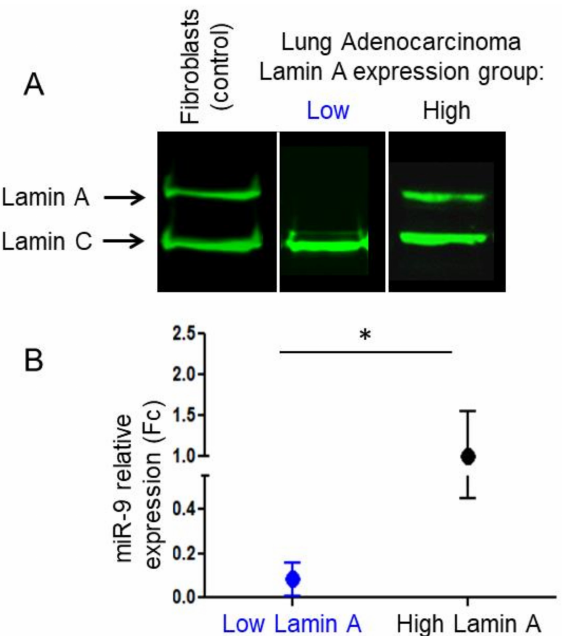
Figure 1. Lamin A and miR-9 expression in total cells from metastatic pleural e ff usions. ( A ) Representative Western blot analysis of protein extracts from patient from the ‘Low Lamin A expression’ group, from patients from the ‘High Lamin A expression’ group and from the total proteins extracts of control dermal fibroblasts using a mouse anti-lamin A / C antibody (Jol2). ( B ) miR-9 relative expression (fold change Fc) quantified by RT-qPCR analysis according to the Lamin A expression group ( p = 0.027, Mann–Whitney). *: p <